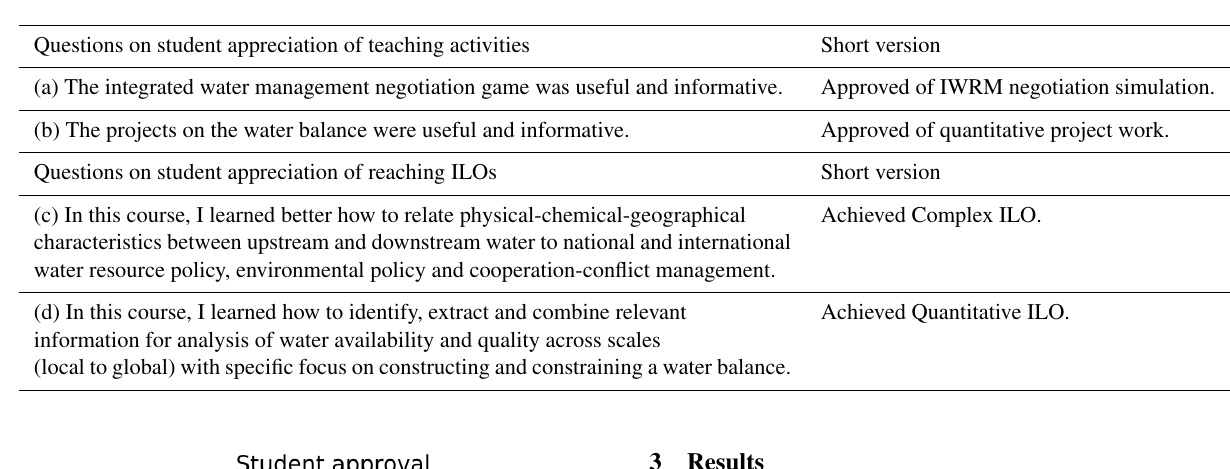
Table 1. Questions on student surveys.